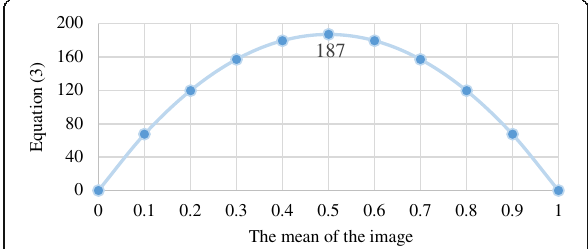
Fig. 10 The maximum of Eq. (3) while varying the mean of the image